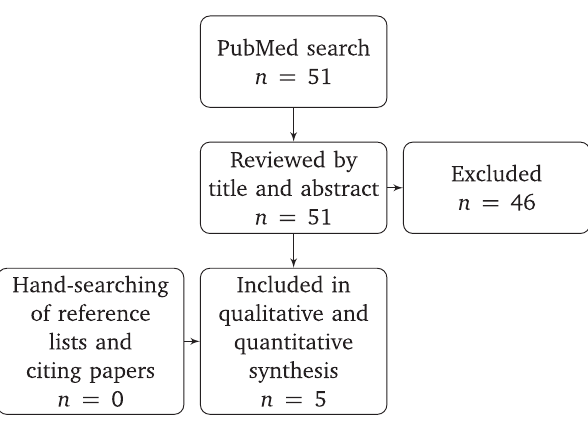
Figure 1. Data inclusion